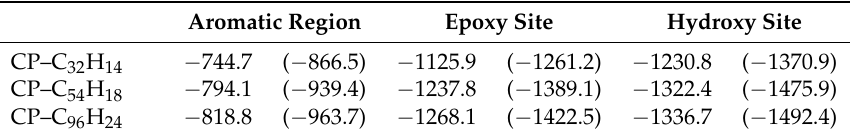
Table 2. Total energy for the interaction of CP adsorbed on GO molecular prototypes of